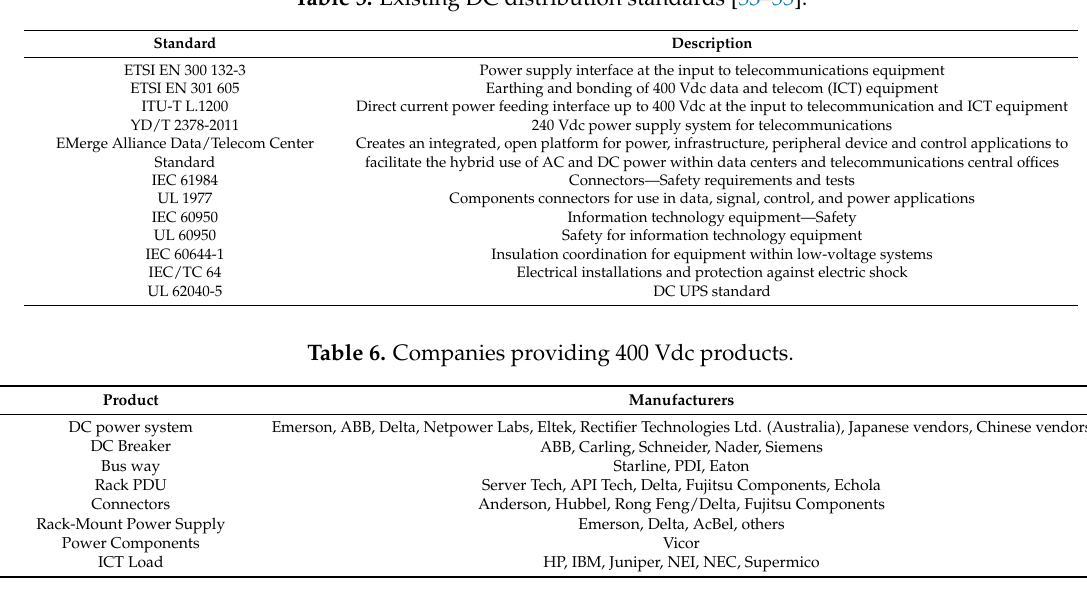
Table 5. Existing DC distribution standards [53–55].